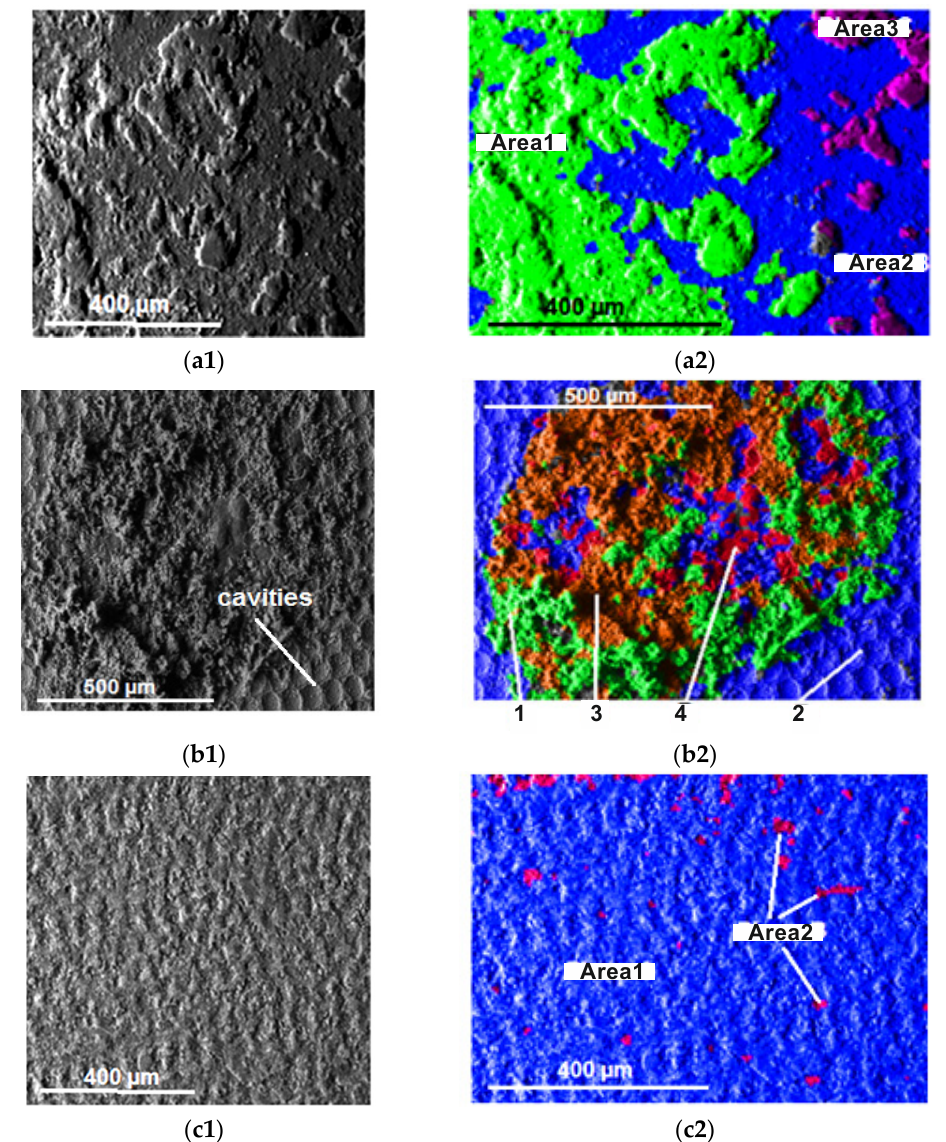
Figure 4. SEM images ( a1 , b1 , c1 ) and EDS mapping ( a2 , b2 , c2 ) of corrosion products. Photos ( a1 , a2 ) correspond to sample 1 (Table 1), ( b1 , b2 ) sample 4 and ( с 1 , c2 ) sample 2.